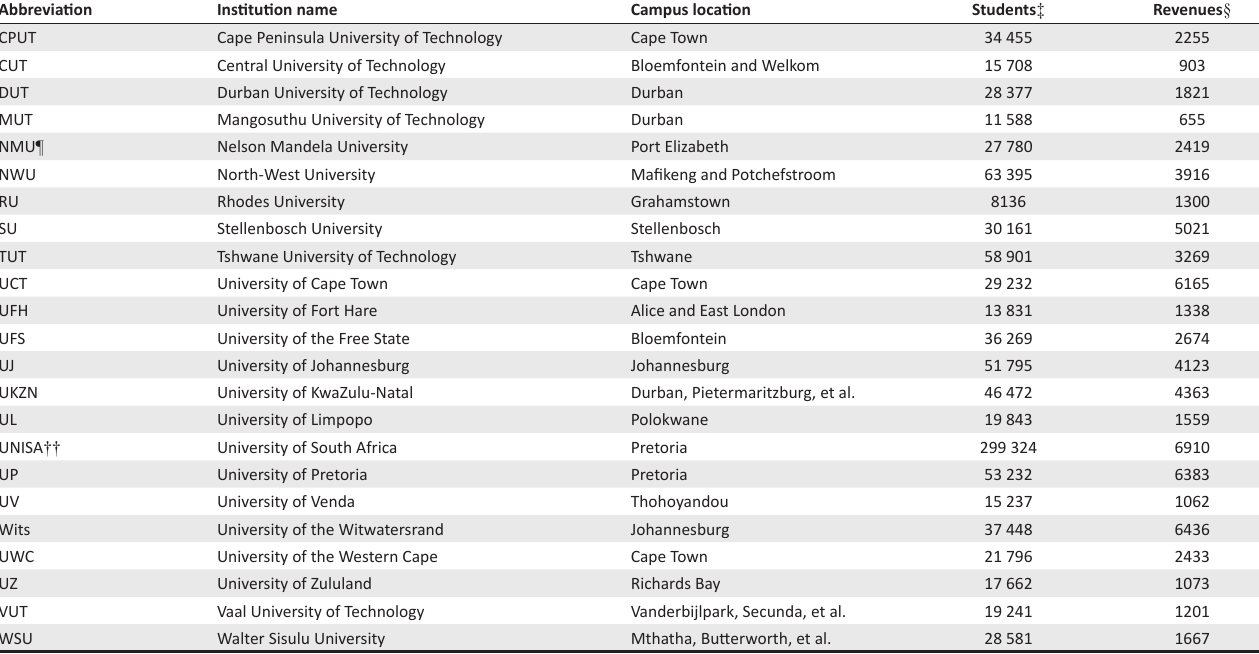
TABLE 1-A1: The South African public universities 2007–2016.